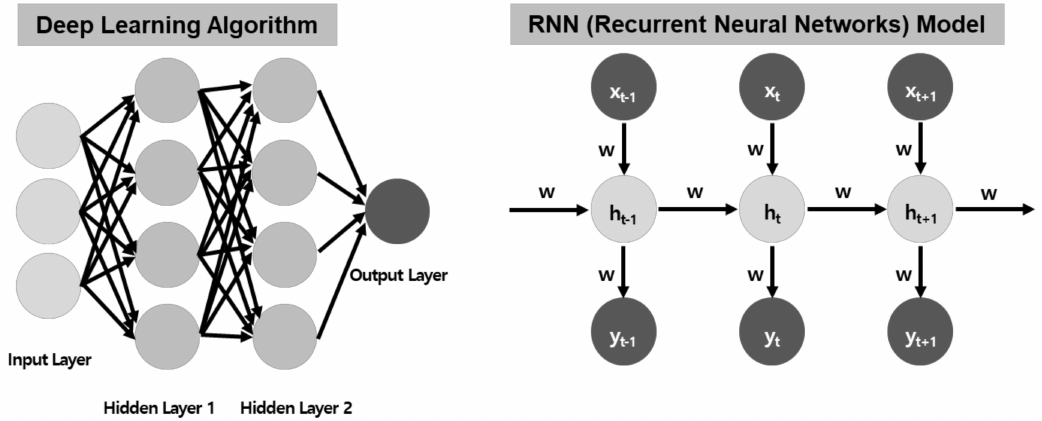
Figure 5. Deep learning algorithm and RNN